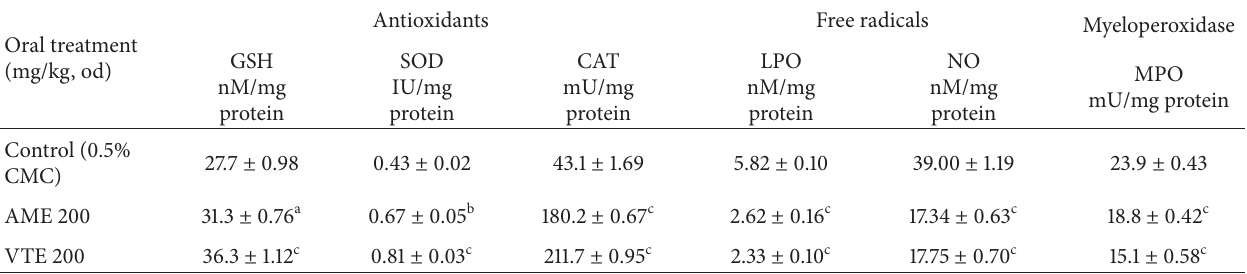
Antioxidants Free radicals Myeloperoxidase GSH SOD CAT LPO NO MPO nM/mg IU/mg mU/mg nM/mg nM/mg mU/mg protein protein protein protein protein protein 15.1 ± 0.58 c